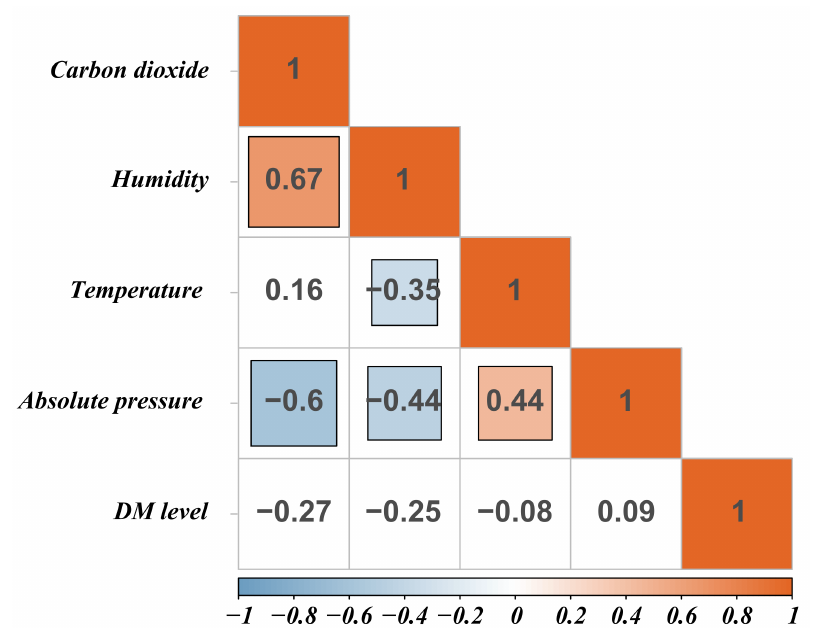
Figure 2. The correlation of high DM level and environmental indicators. Blank background color indicates not significant. The darker the color, the greater the